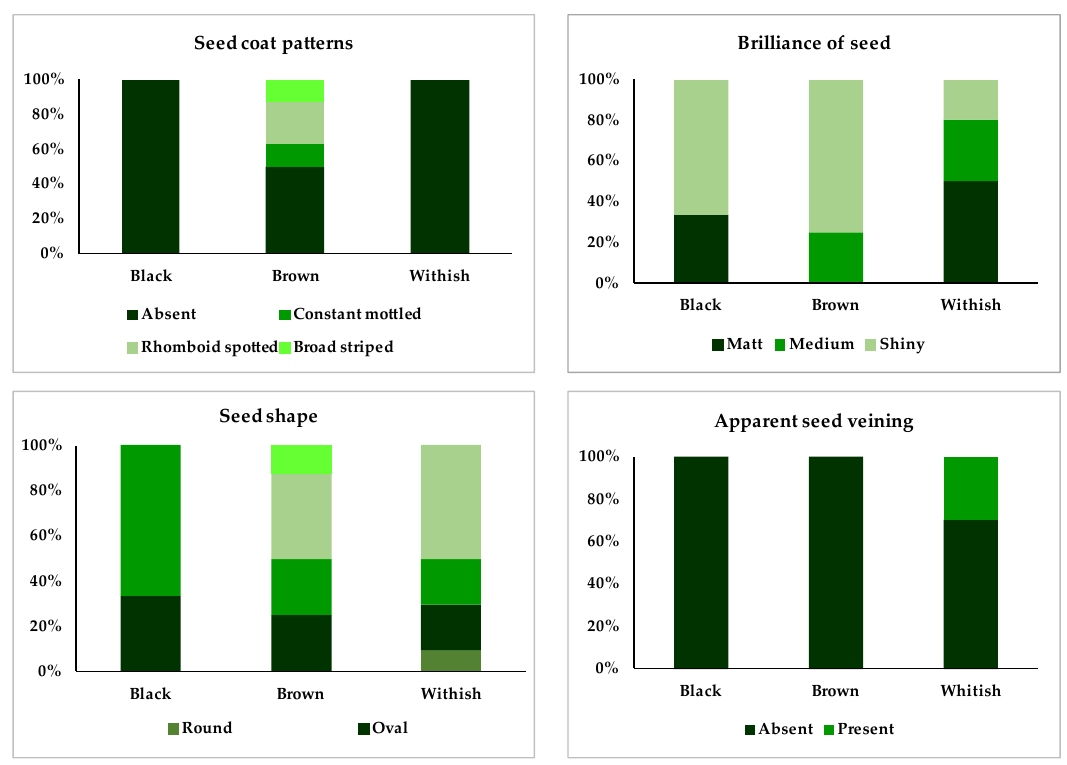
Figure 8. Seed traits of the 24 P. vulgaris accessions evaluated.